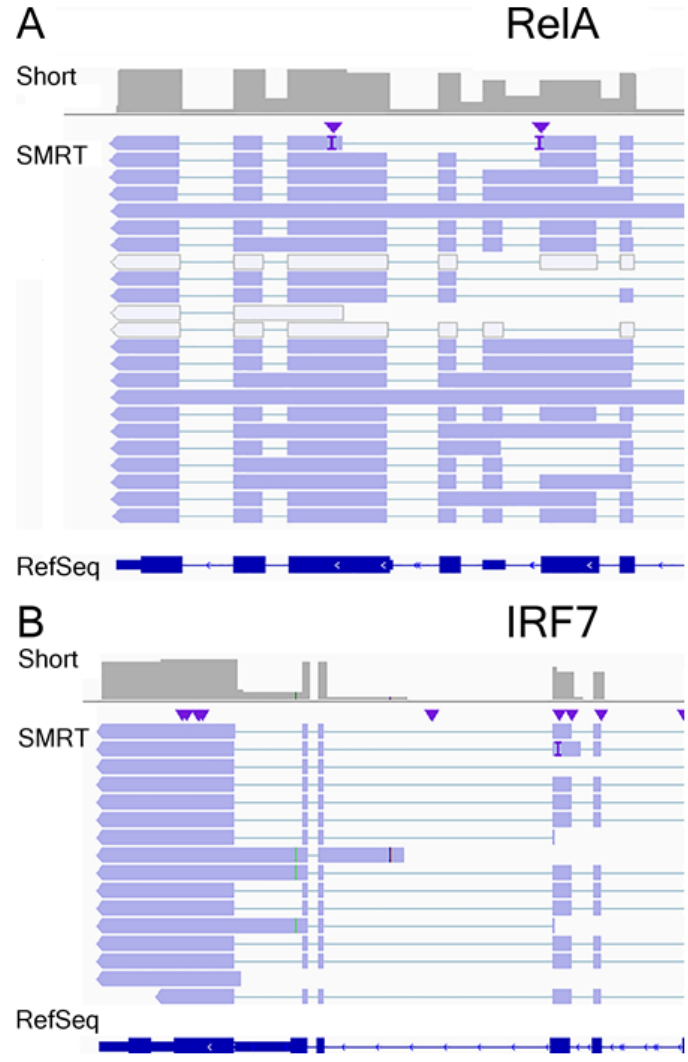
Figure 7. AS of NF κ B/RelA and interferon regulatory factor (IRF7) mRNAs. Integrated Genomic Browser view of pile-up of short-read RNA sequencing (Short, in gray) and individual transcripts (SMRT) for ( A ) RelA and ( B ) IRF7. Genome organization detailing intron–exon boundaries are indicated in dark blue at the bottom. The abundance of short-read sequencing is a most reliable estimate of relative expression levels. Note the presence of exon exclusion, exon skipping, and intron inclusion in transcripts quantified by SMRT sequencing.